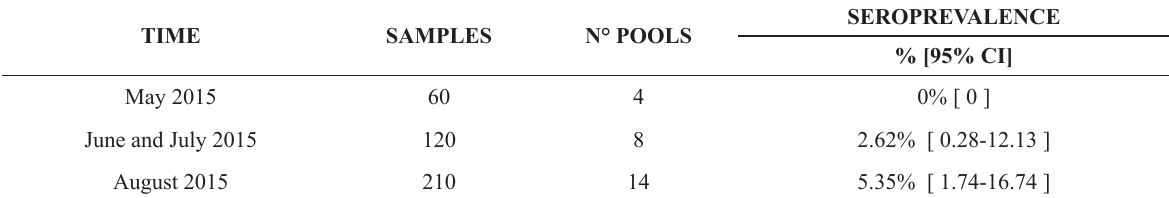
Zika virus seroprevalence among persons randomly recruited from the donated blood